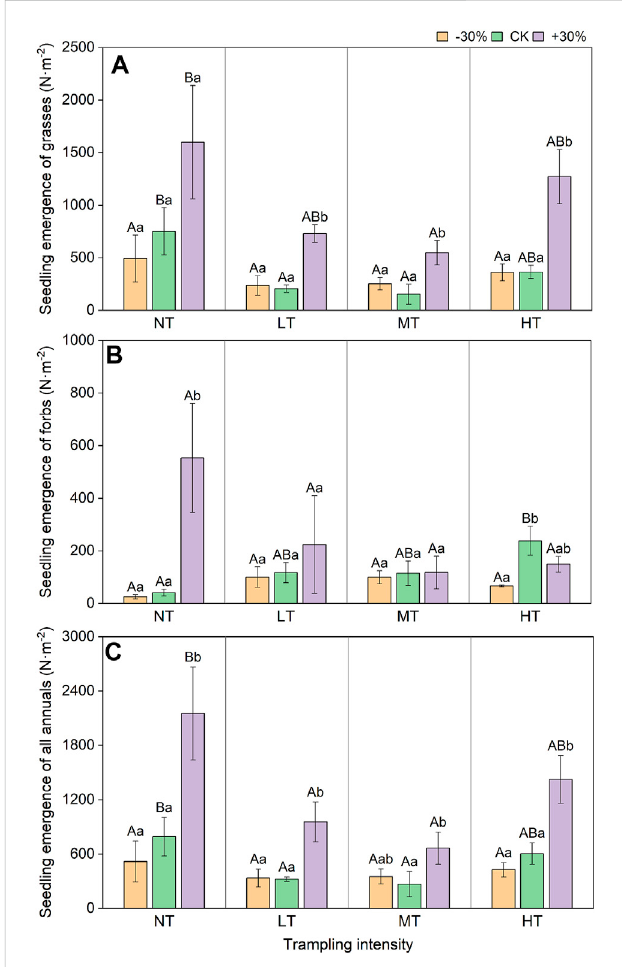
FIGURE 1 Effectsofprecipitationvariationontotalseedlingemergenceunder different trampling intensities. Seedling emergence of grasses (A) ; Seedling emergence of forbs (B) ; Seedling emergence of all annuals (C) . NT, no trampling; LT, light trampling; MT, moderate trampling; HT, heavy trampling. − 30%, decreased precipitation by 30%; CK, ambient precipitation; +30%, increased precipitation by 30%. Different lower- case letters indicate signi fi cant difference among precipitation treatments under same trampling intensity at 0.05 level, different capital letters indicate signi fi cant difference among trampling treatments in same precipitation condition at 0.05